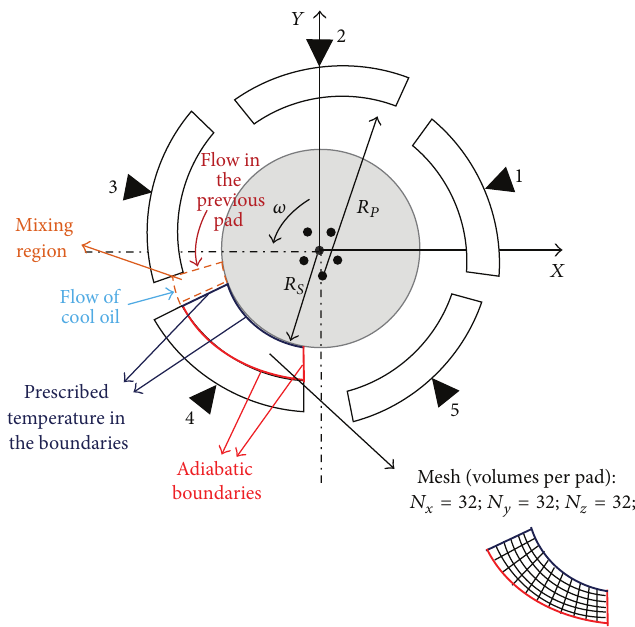
Figure 4: Schematic representation of the mesh and the boundary conditions.